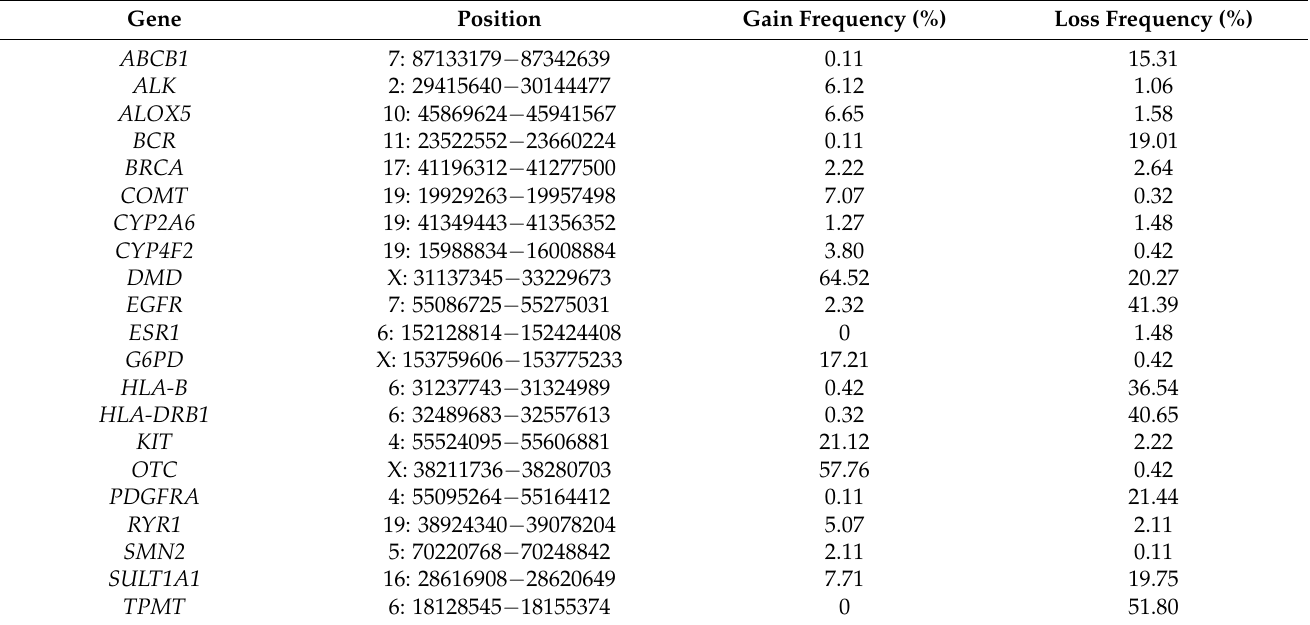
Table 2. Copy number variations for pharmacogenes with a frequency of more than 1% in Koreans.